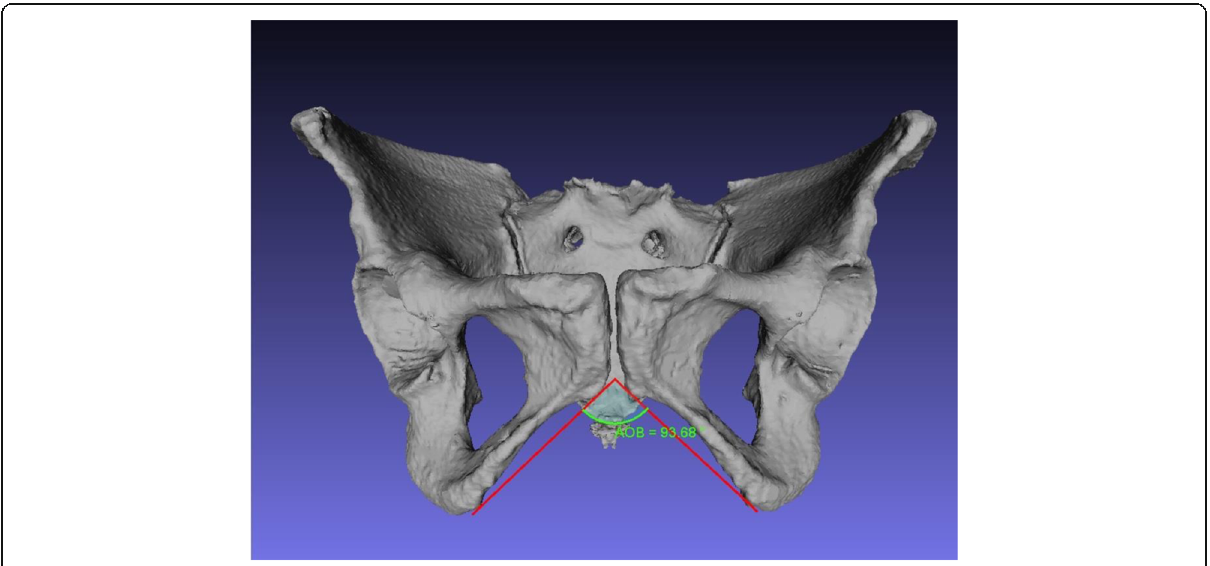
Fig. 2 Pelvic image showing subpubic angle measurement using the MeshLab and OnScreenProtractor (Method